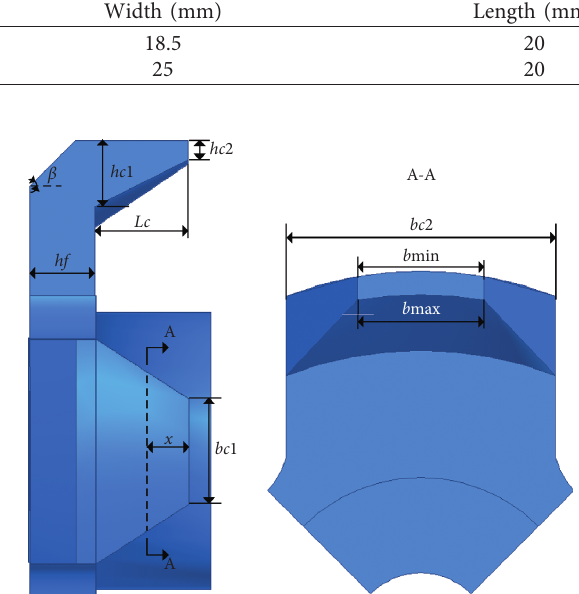
Figure 6: Claw pole size relationship